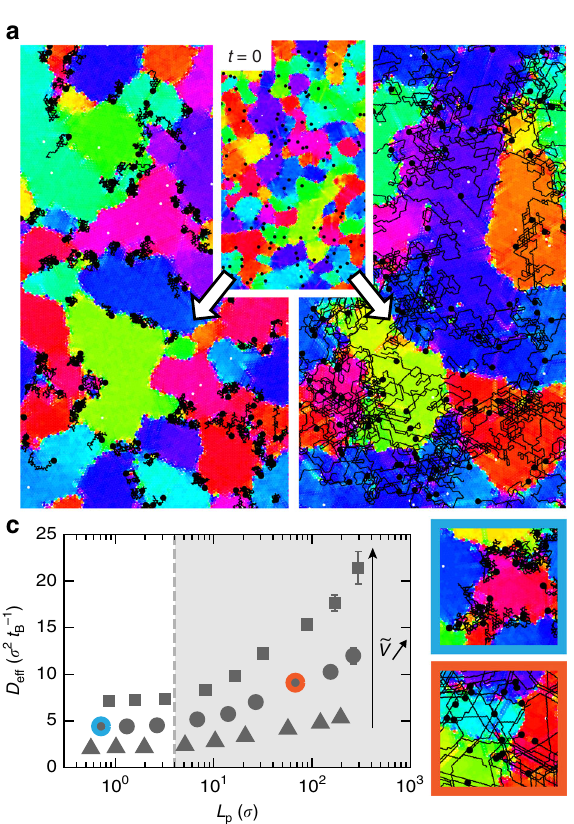
Fig. 3 Numerical simulation of a colloidal monolayer, with added active particles of different persistence. Evolution of the system starting from the same initial con fi guration (inset, t = 0) with a fraction α = 0.6% of active intruders, with same speed but different persistence time, leading to persistence lengths of a L p = 0.3 σ , and b L p = 7 σ comparable to experiments. The dynamics of the swimmers change qualitatively with the persistent time: they navigate along the directions of the crystal in one case ( b ) and localize at the grain boundaries in the other ( a ). The colors correspond to the local hexactic orientational order as in (Fig. 1). The active particles are shown as black points bigger than their actual size to improve visibility, and black lines trace their trajectories within the 3.10 6 time steps preceding the snapshots. c The diffusivity D eff of the passive particles shows a dynamic transition set by the persistence length L p of the active dopants and plateaus for L p ≤ 0.4 σ . Active dopants co-localize at the grain boundary for L p ≤ 0.4 σ and travel in bulk otherwise, as illustrated with typical trajectories on the side panels, which correspond to the highlighted points on the graph. The qualitative change in the annealing mechanism, as visible on panels a and b , coincides with a transition in energy transfer between the dopants and the passive